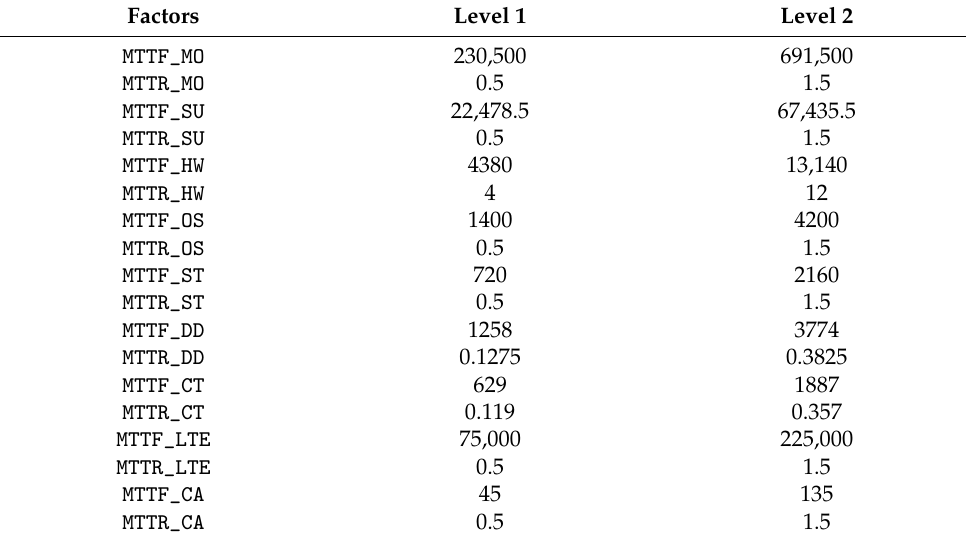
Table 5. Factors (in hours) and design of experiment (DoE) levels for the availability